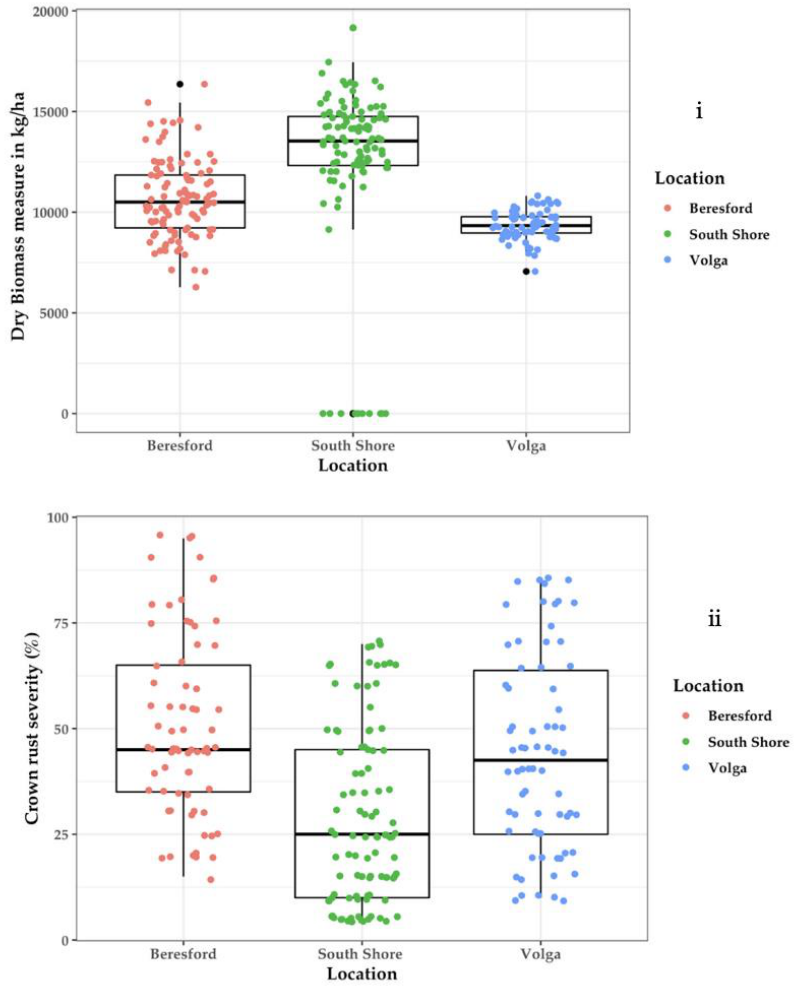
Figure 6. Boxplot representation of dry biomass yield ( i ) and crown rust severity ( ii ) for thirty-five oat genotypes evaluated at three South Dakota locations. Table 3. Pearson correlation coefficient ( r ) of dry biomass with plant height and crown rust severity.